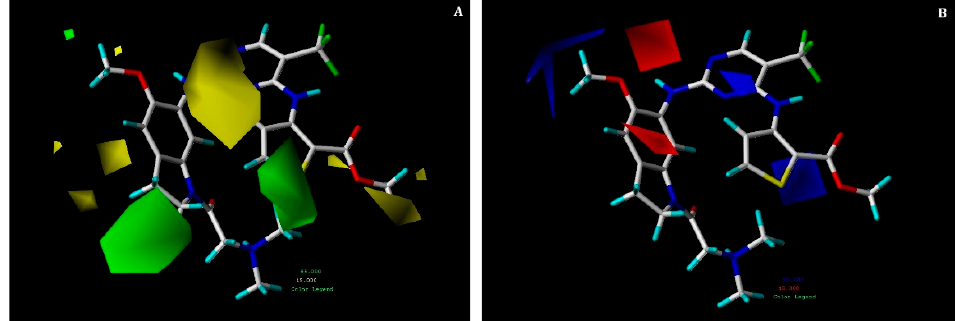
Figure 6. Contour maps for the selected CoMFA model. ( A ) Steric contour map; ( B ) electrostatic contour map; green contours show the region is favorable for bulky substitutions, and yellow contours show the region is unfavorable; blue contours favor electropositive substitutions, whereas red contours favor electronegative substitutions.